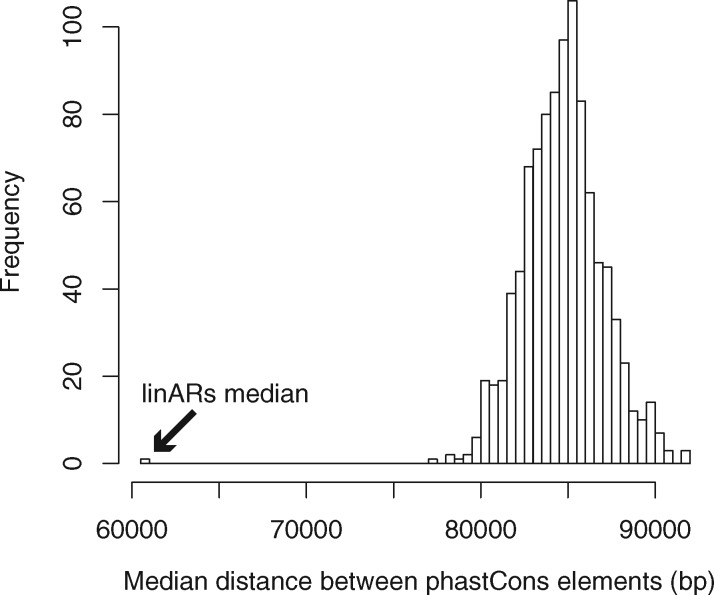
The linARs are more clustered than phastCons elements. The distribution of median distances between phastCons elements was computed using 1000 random draws of 5916 phastCons elements from the full set. The minimum sampled pairwise distance between phastCons elements (∼77 kb) was much larger than the median distance between pairs of linARs (60.8 kb; arrow). This analysis shows that linARs are significantly closer to each other in the human genome than are random sets of the same number of phastCons elements (P < 0.001).